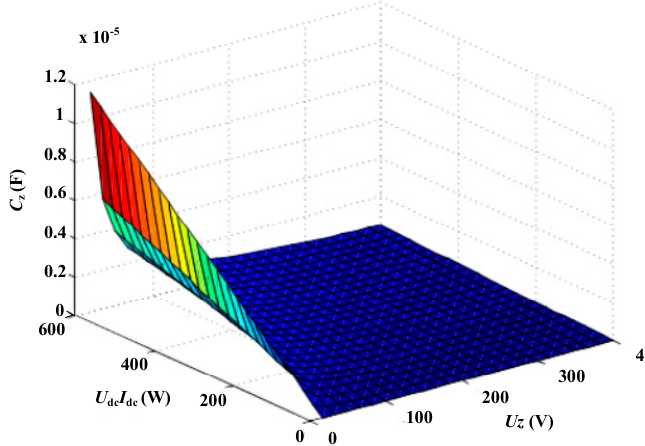
Figure 6. Selection range of capacitance in the power decoupling circuit.